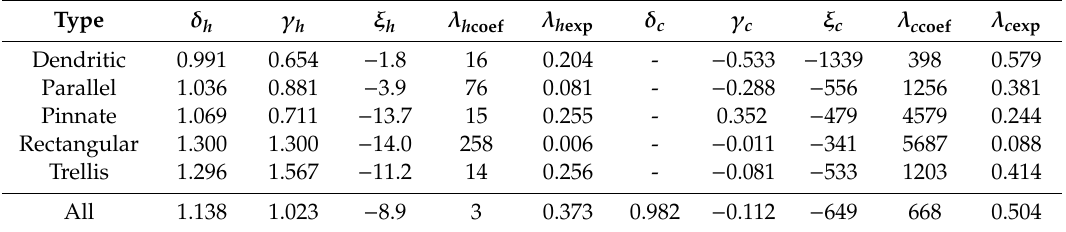
Table 3. Estimated parameters of the Johnson SB distribution for A sh ( left ) and A sc ( right ).